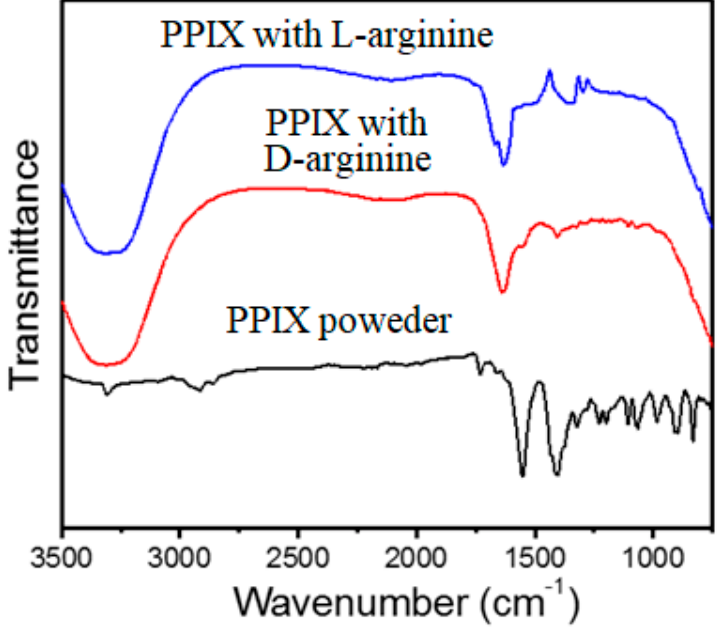
Figure 5. FTIR spectra of PPIX, PPIX/ D -arginine and PPIX/ L -arginine at a 1:4 molar ratio.